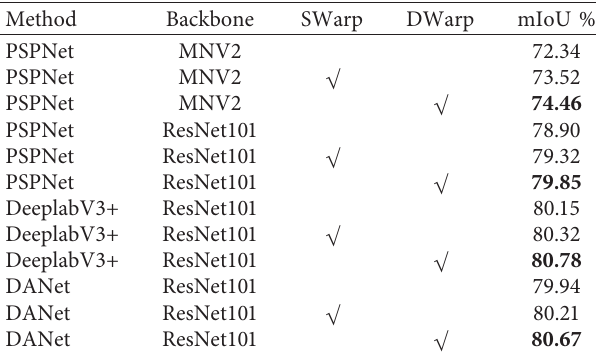
Table 5: Comparison of our DWNet with different network structures on the Cityscapes validation